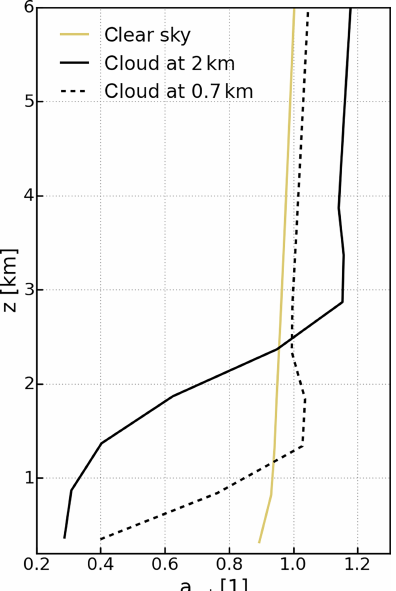
null-space error is small (Buchwitz et al., 2004; Gloudemans et al., 2008) and a direct comparison of the retrieved column with CO column reference measurements is possible while count for averaging kernel effects. Clouds can easily lead to tween the true vertical trace gas profile and the reference pro- file to be scaled by the retrieval (Borsdorff et al., 2014).